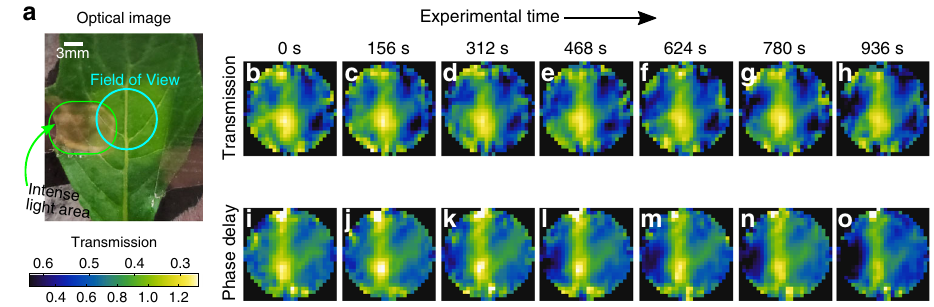
Fig. 5 THz leaf imaging. a Optical image of the leaf, from an Achyranthes aspera plant, used in the experiment. The THz fi eld-of-view is indicated here along with the area illuminated by an intense white-light source (~3 sun illumination). b – h ( i – o ) THz transmission (phase delay) of the leaf shown in part a at different points in time (experimental time shown on top). Note that the transmission images show an average from 0.3 to 0.8 THz, P T ¼ n i j E samp ð ω i Þ = E ref ð ω i Þj = n , and the phase delay images show the averaged unwrapped phase, Φ ¼ ¼ 1 transmission colourscale been inverted. Further, the THz images have been deconvolved, using deconvblind function in Matlab R2016a, by calculating